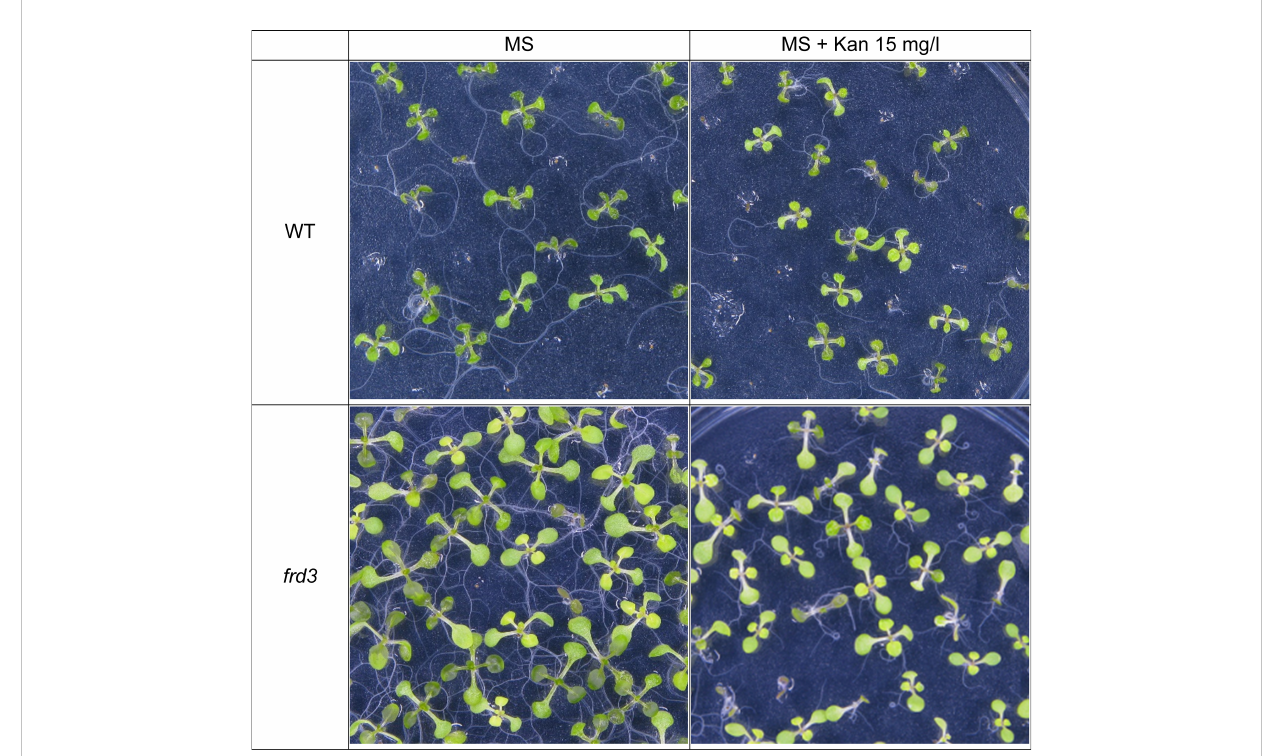
FIGURE 5 Growth of WT Arabidopsis seedlings and frd3 mutants on MS medium with or without Kan (15mg/l) for 10 days.